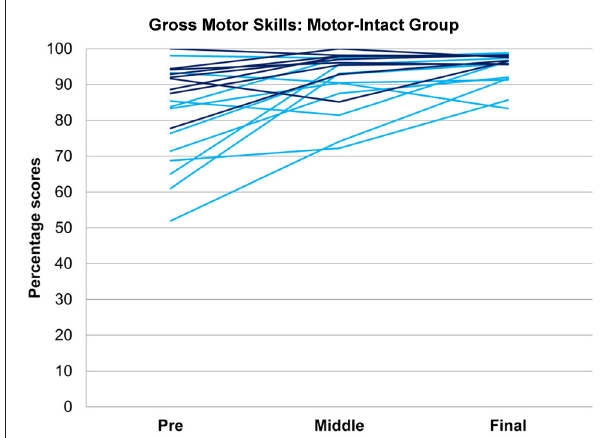
FIGURE 4 | Gross motor scores over time in the receptive-impaired (light blue) and receptive-intact (dark blue) subgroups of the motor-intact group. The receptive-impaired group ended the intervention with lesser gross motor scores, and this difference was driven by many individuals who began with more severe gross motor deficits and, though they improved at rates similar to those of the receptive-intact subgroup, did not yet approach ceiling by the end of the